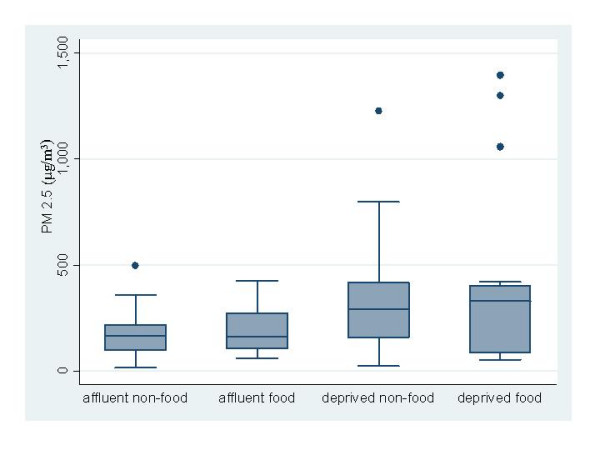
Box plots of fine particle levels by category of pub in μg/m3.